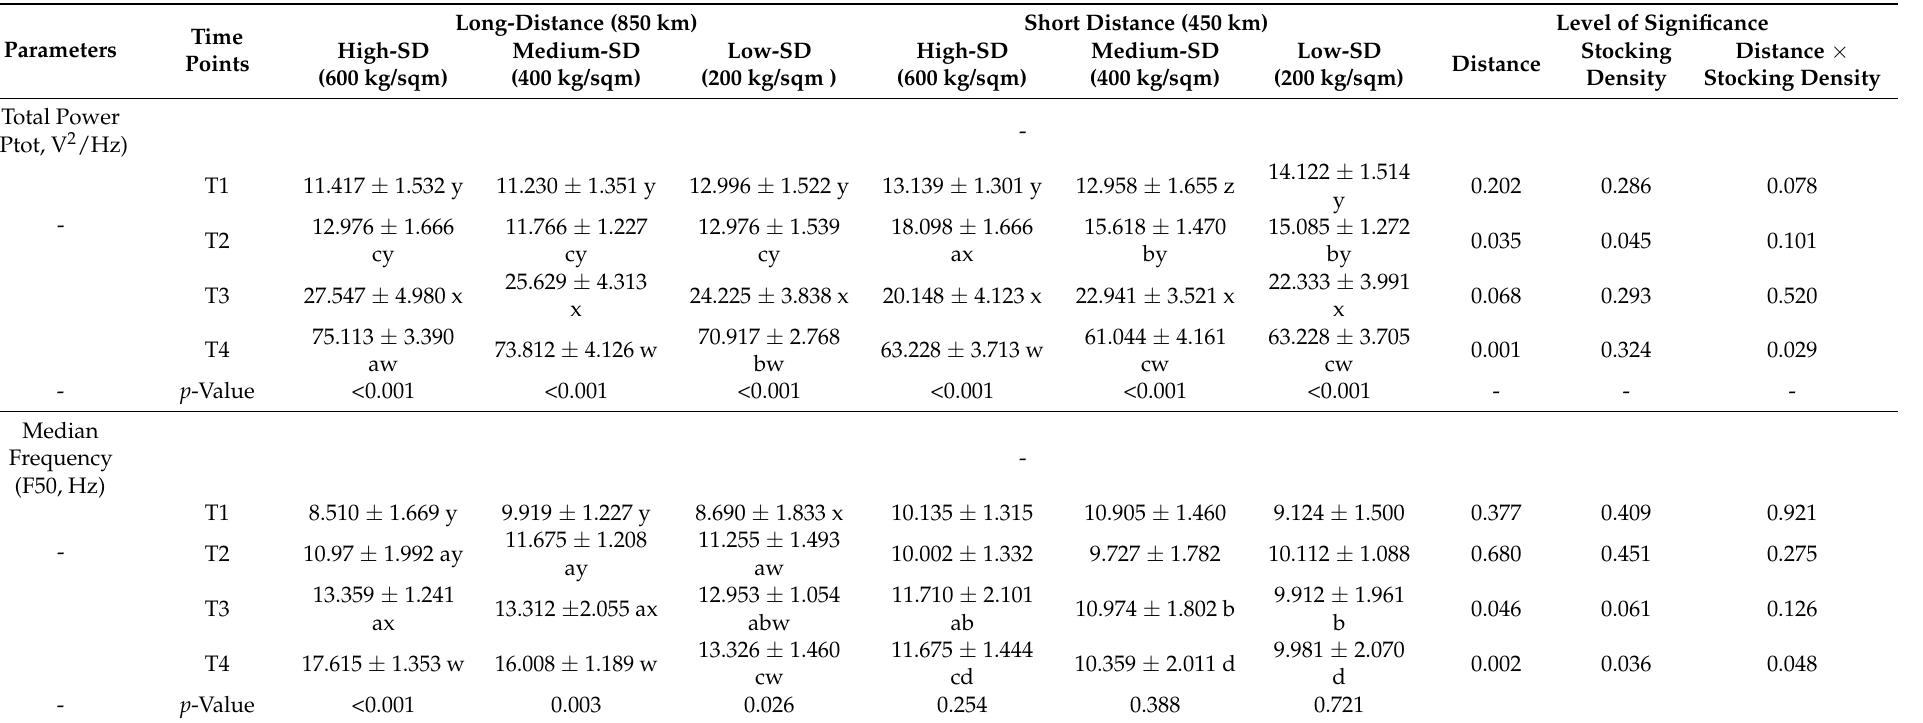
Table 3. Influence of distances and stocking density on the total power (Ptot) and median frequencies (F50) on the encephalogram of Brahman crossbred cattle (Mean ± SE).